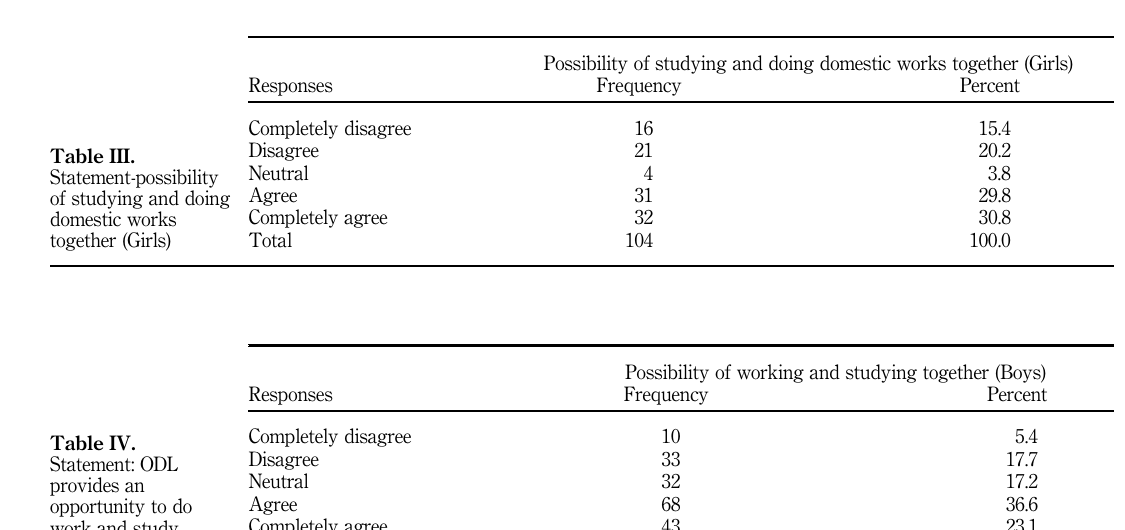
provides an opportunity to do work and study together